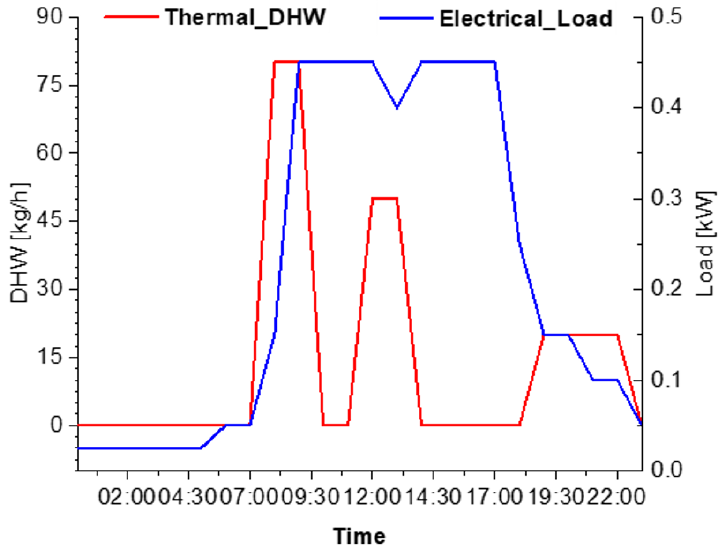
Figure 5. Daily profile of thermal and electrical